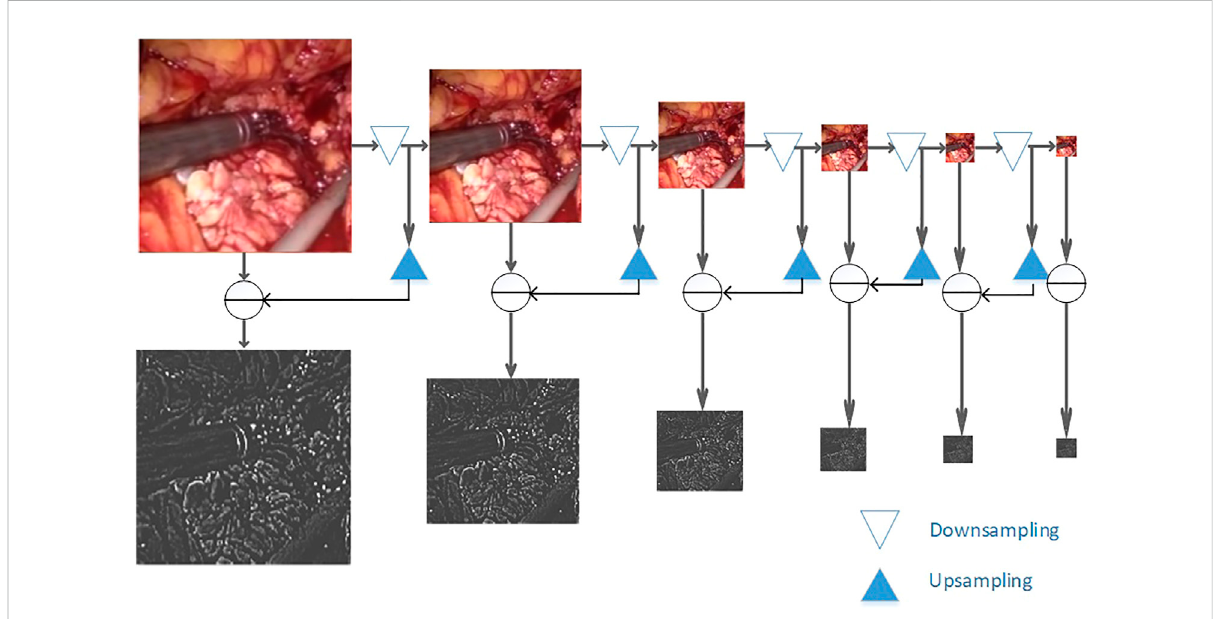
FIGURE 4 Laplacian image pyramid decomposition.